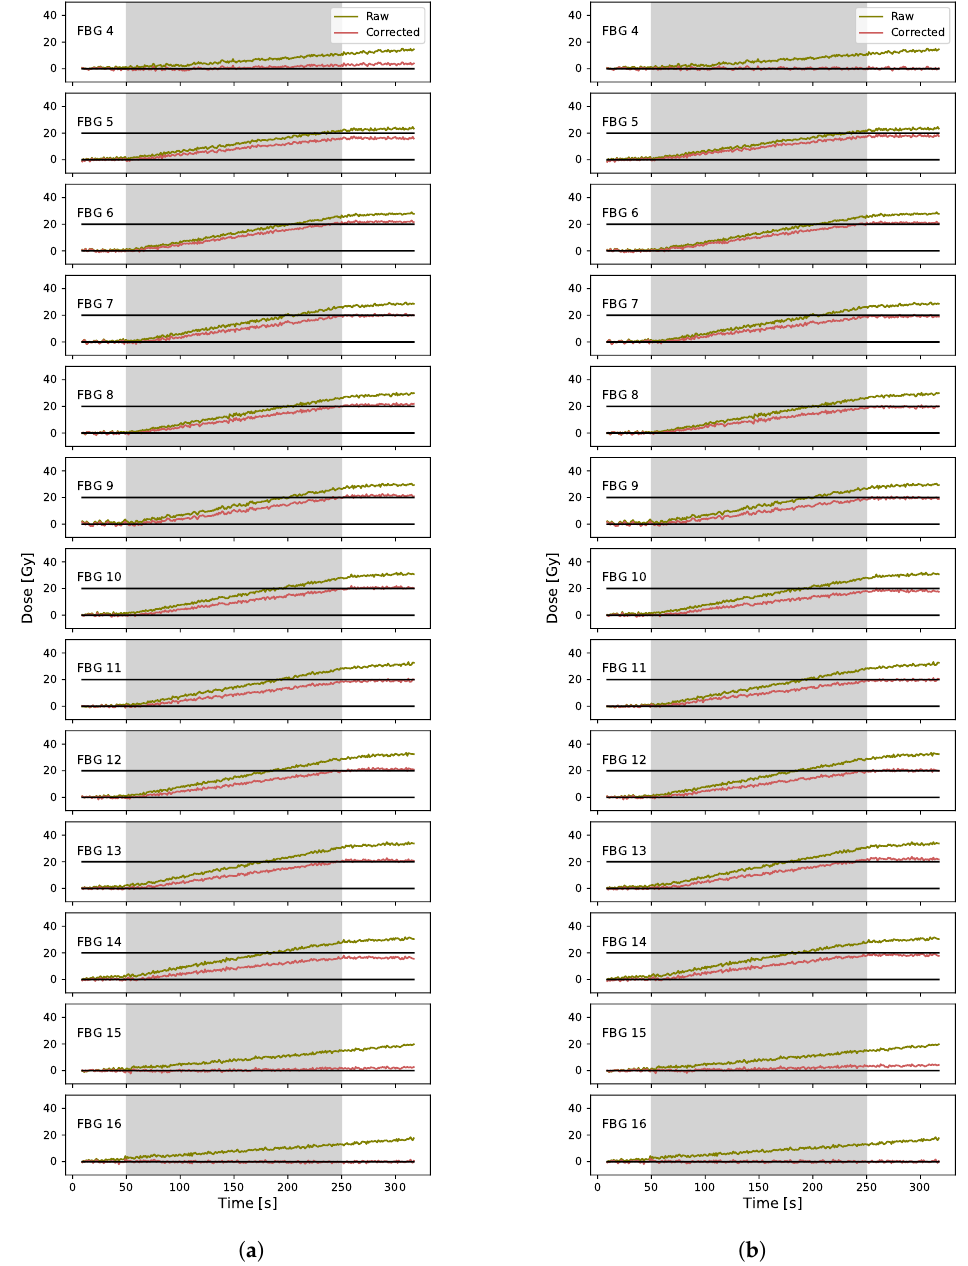
Figure A1. Raw and corrected data obtained using the ( a ) PPD technique and the ( b ) ITG